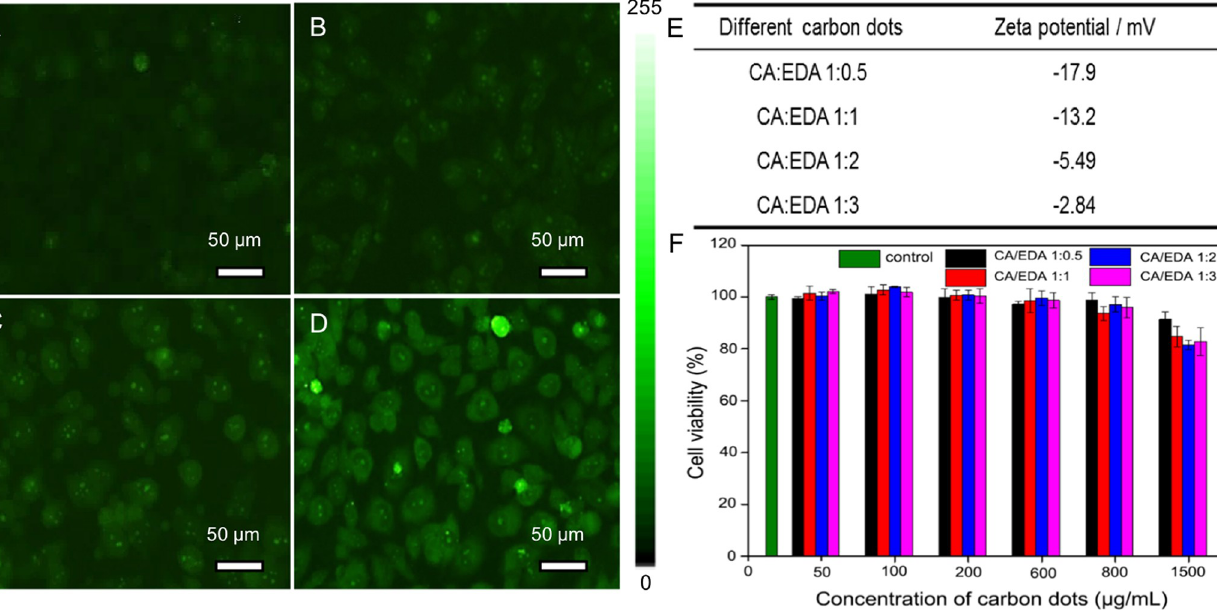
Fig 2. Fluorescent images of HeLa cells incubated with 400 μ g/mL of carbon dots with the molar ratio of CA: EDA at 1:0.5(A), 1:1 (B), 1:2 (C), 1:3 (D) for 24 h (under blue light excitation). Table of the Zeta potentials of carbon dots with different molar ratio of CA: EDA (E). Viability of HeLa cells incubated with various carbon dots with different concentrations for 24 h